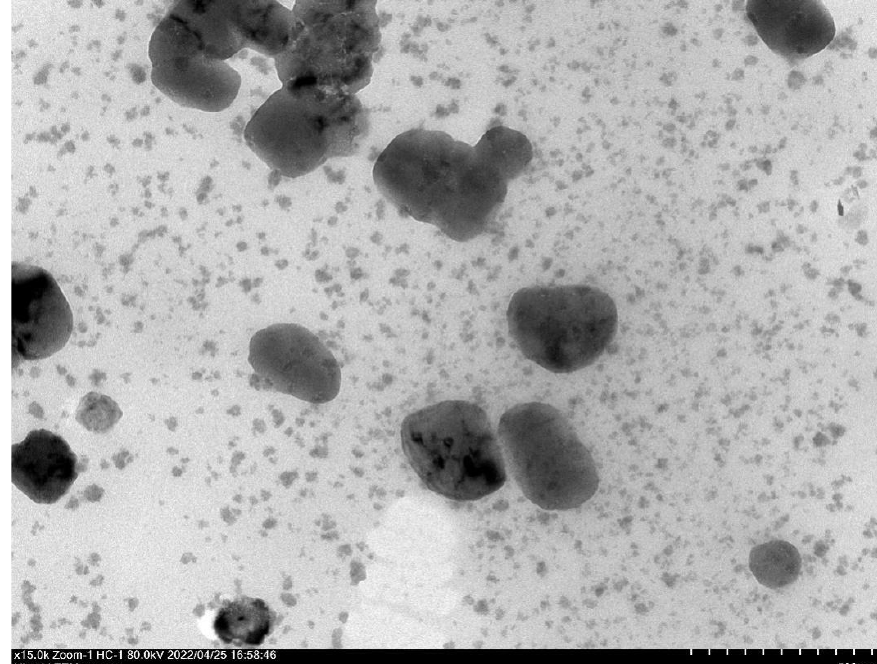
Figure 1. TEM image of CSNP-CAs.